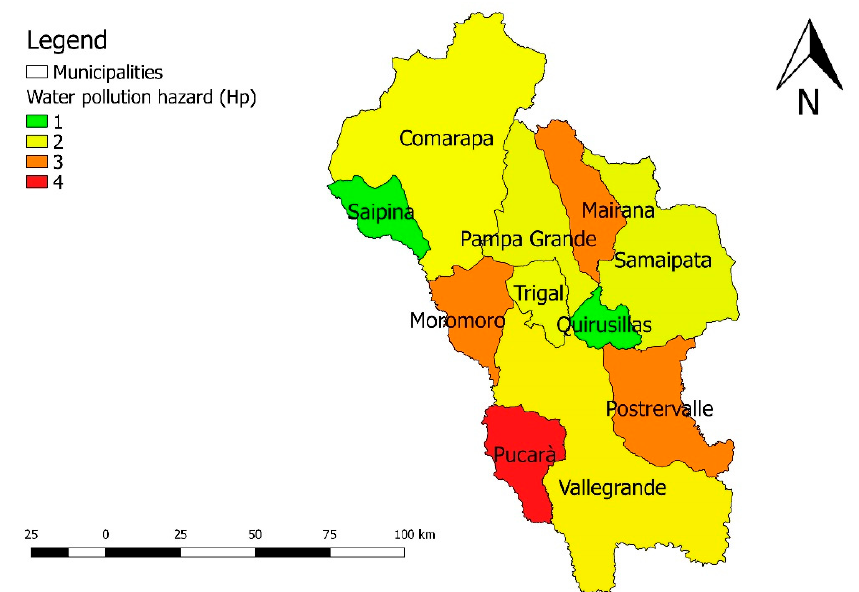
Figure 5. Water pollution hazard (Hw) map of the "Valles Cruceños" region, Hw varies from 1